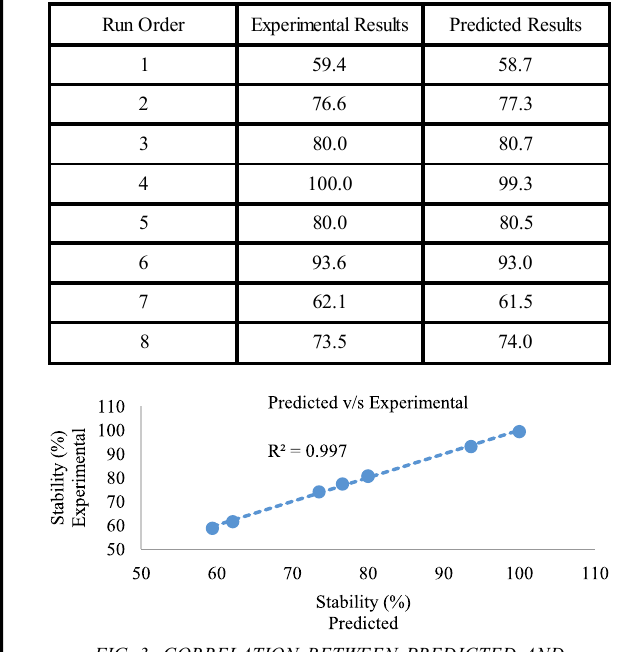
TABLE 4. COMPARISON BETWEEN EXPERIMENTAL AND PREDICTED RESULTS